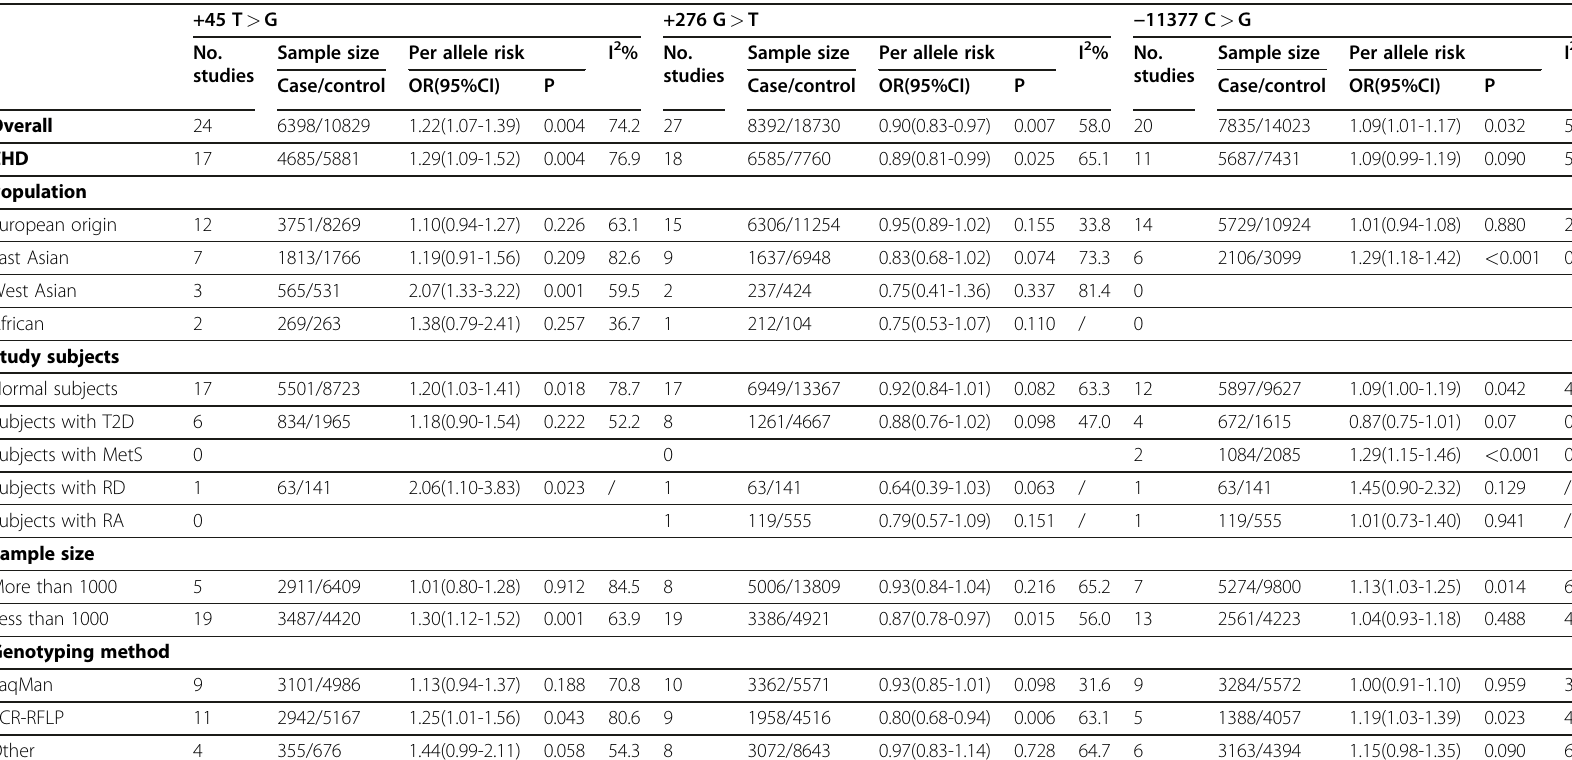
Table 2 Meta-analysis of ADIPOQ gene polymorphisms and